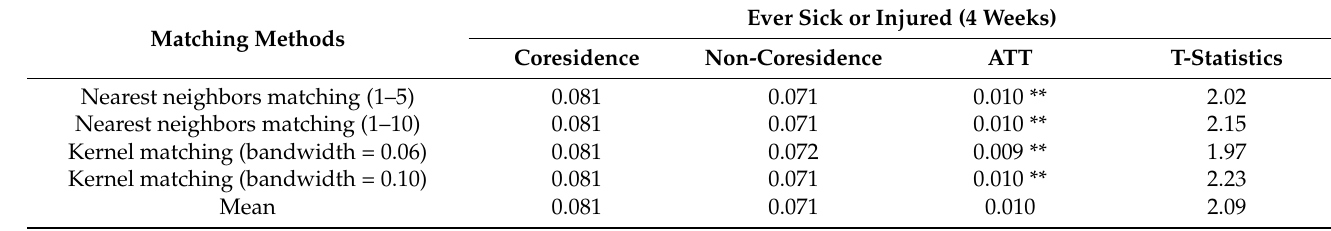
Table 6. Effect of grandparents’ coresidence on children’s and adolescents’ recent illness.